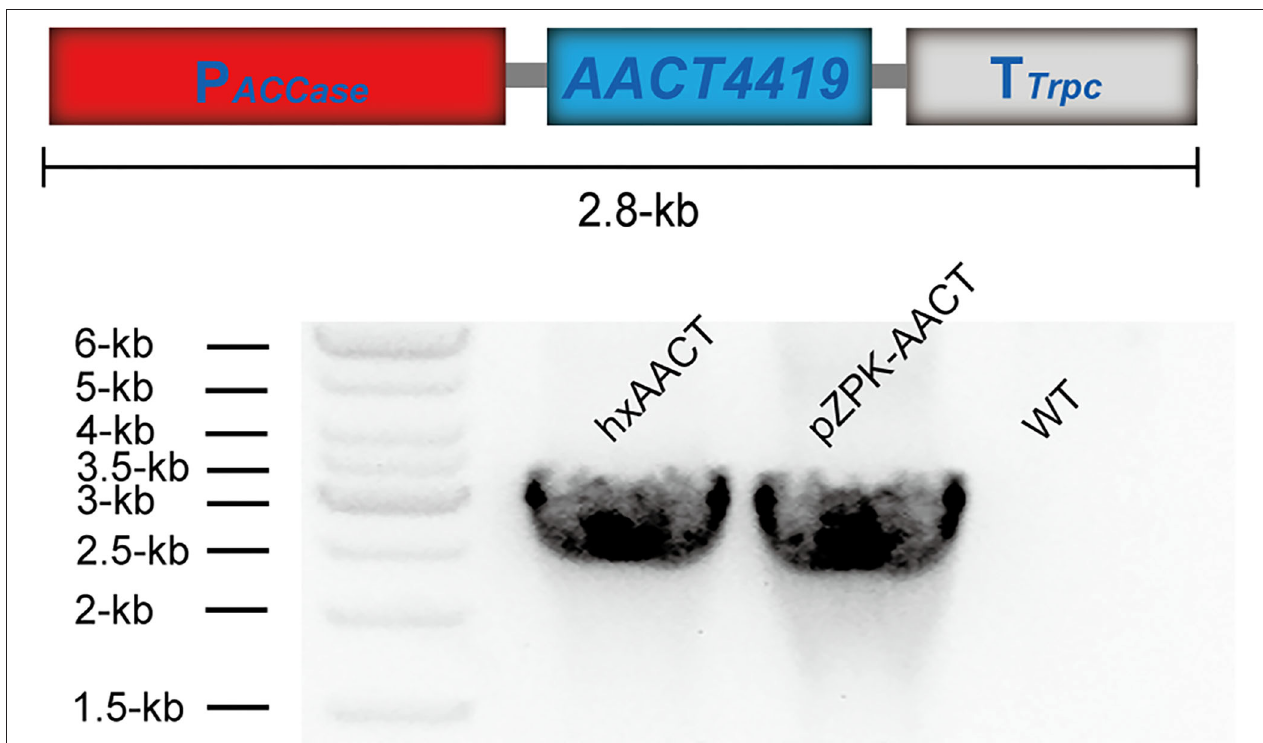
FIGURE 2 | The schematic diagram of the AACT4419 expression cassette and the diagnostic PCR validation of the AACT4419 expression cassette.